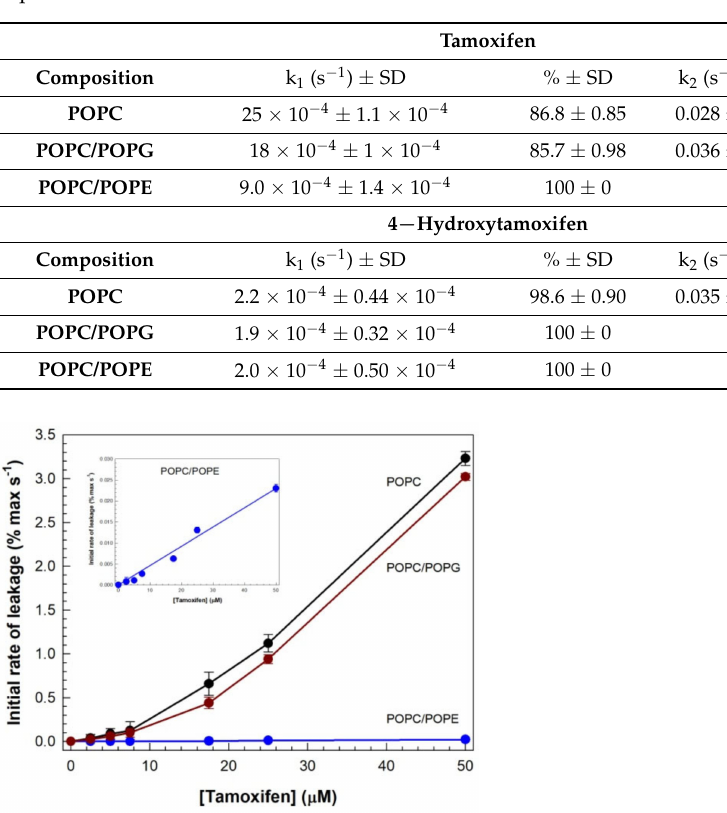
Table 2. Rate constants, and their relative proportions, for TMX- and HTMXinduced CF leakage from unilamellar vesicles of various compositions, as determined by fitting the data shown in Figure 3 to Equation (1). Drug concentration was 17.5 µ M. Data correspond to the mean of three independent experiments ± SD.